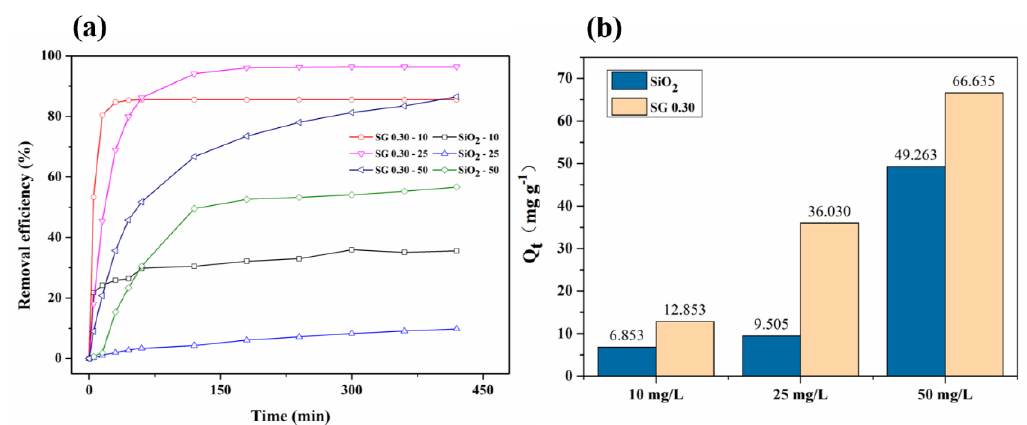
Figure 9. ( a ) Removal e ffi ciency of SiO 2 and rGO / SiO 2 with di ff erent initial concentrations of NR. ( b ) Plot of the saturated amount of adsorbed NR at equilibrium versus the initial concentration at room